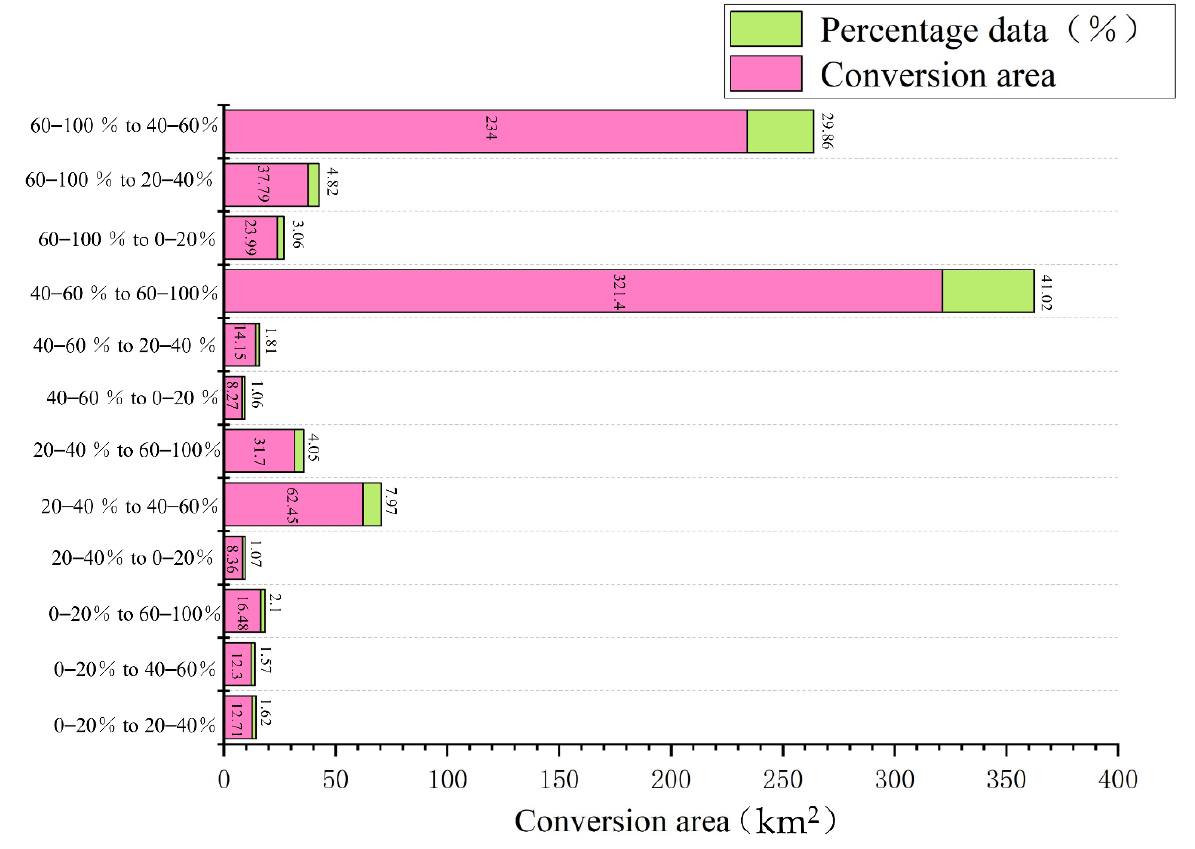
Figure 11. Successive area changes that occurred in the 1989–2021 time scenario.